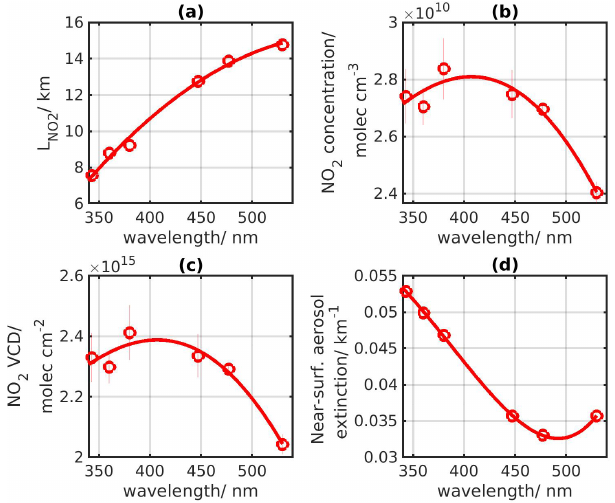
Figure 6. (a) Corresponding L NO , (b) near-surface NO 2 concen- 2 trations, (c) NO 2 VCDs, and (d) aerosol optical densities as a func- tion of the six wavelengths used in the retrieval (11 September 2018, 11:51UTC, 123.5 ◦ azimuthal